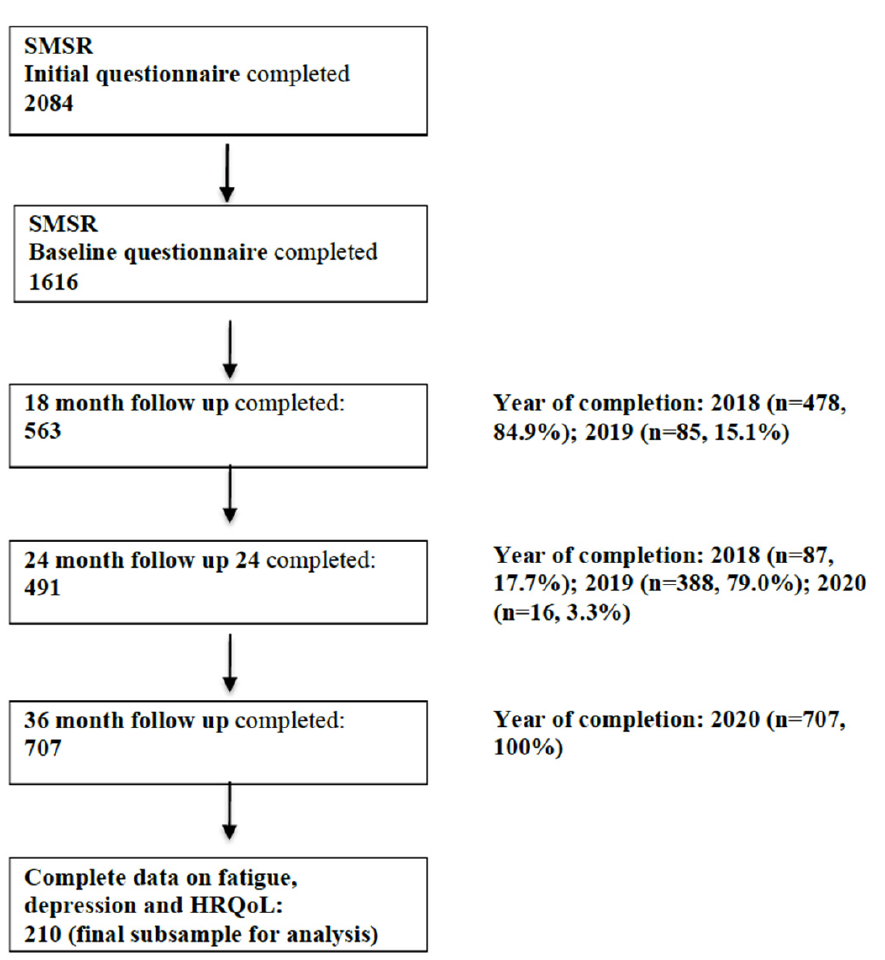
Figure 1. Flow chart describing the study sample of the Swiss Multiple Sclerosis Registry (numbers reflect numbers of persons; status quo: 8 June 2020). Abbreviations: SMSR = Swiss MS Registry and HRQoL = Health-related quality of life.